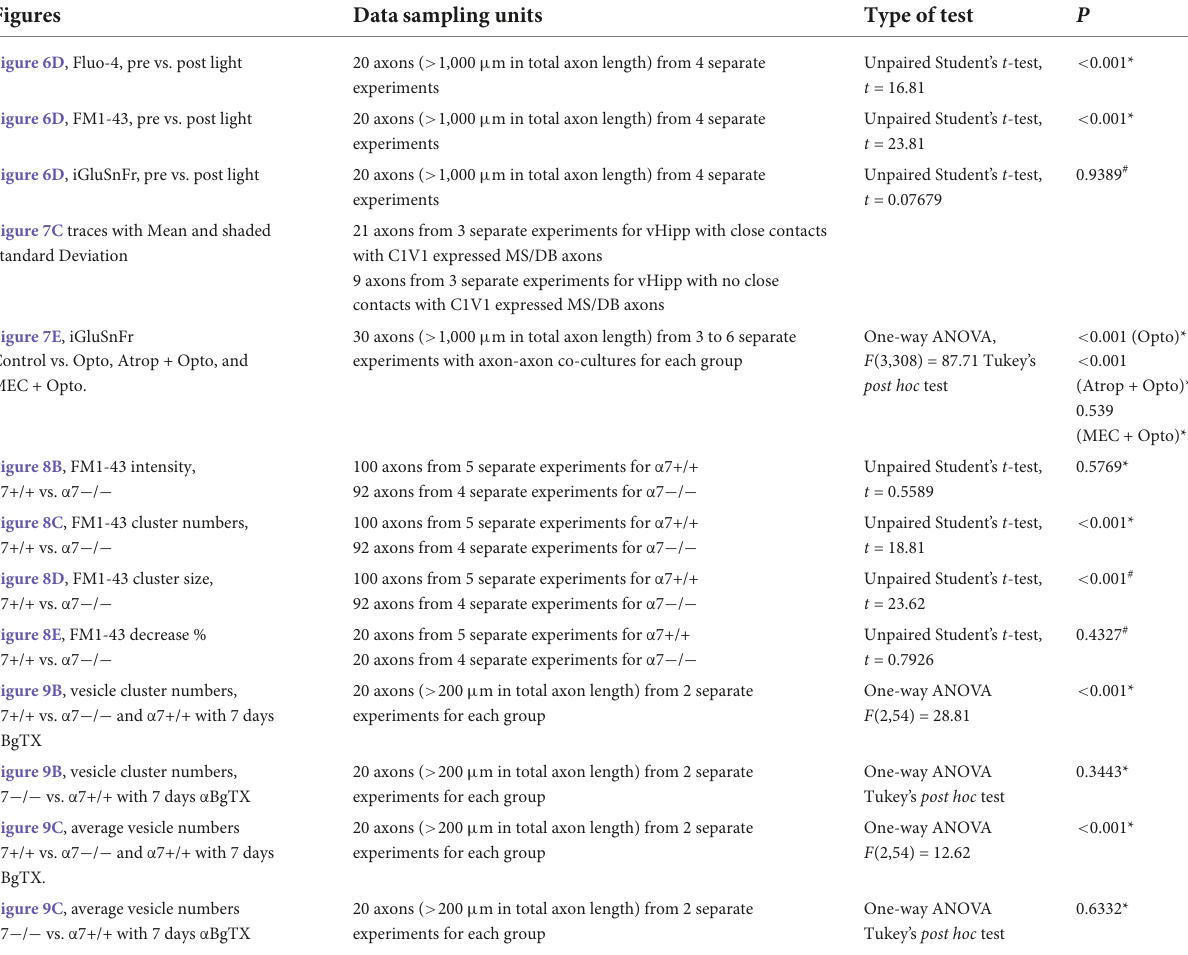
< 0.001* 0.9389 # < 0.001 (Opto)* < 0.001 (Atrop + Opto)* 0.539 (MEC + Opto)* 0.5769* < 0.001* < 0.001 # 0.4327 # < 0.001* 0.3443* < 0.001*